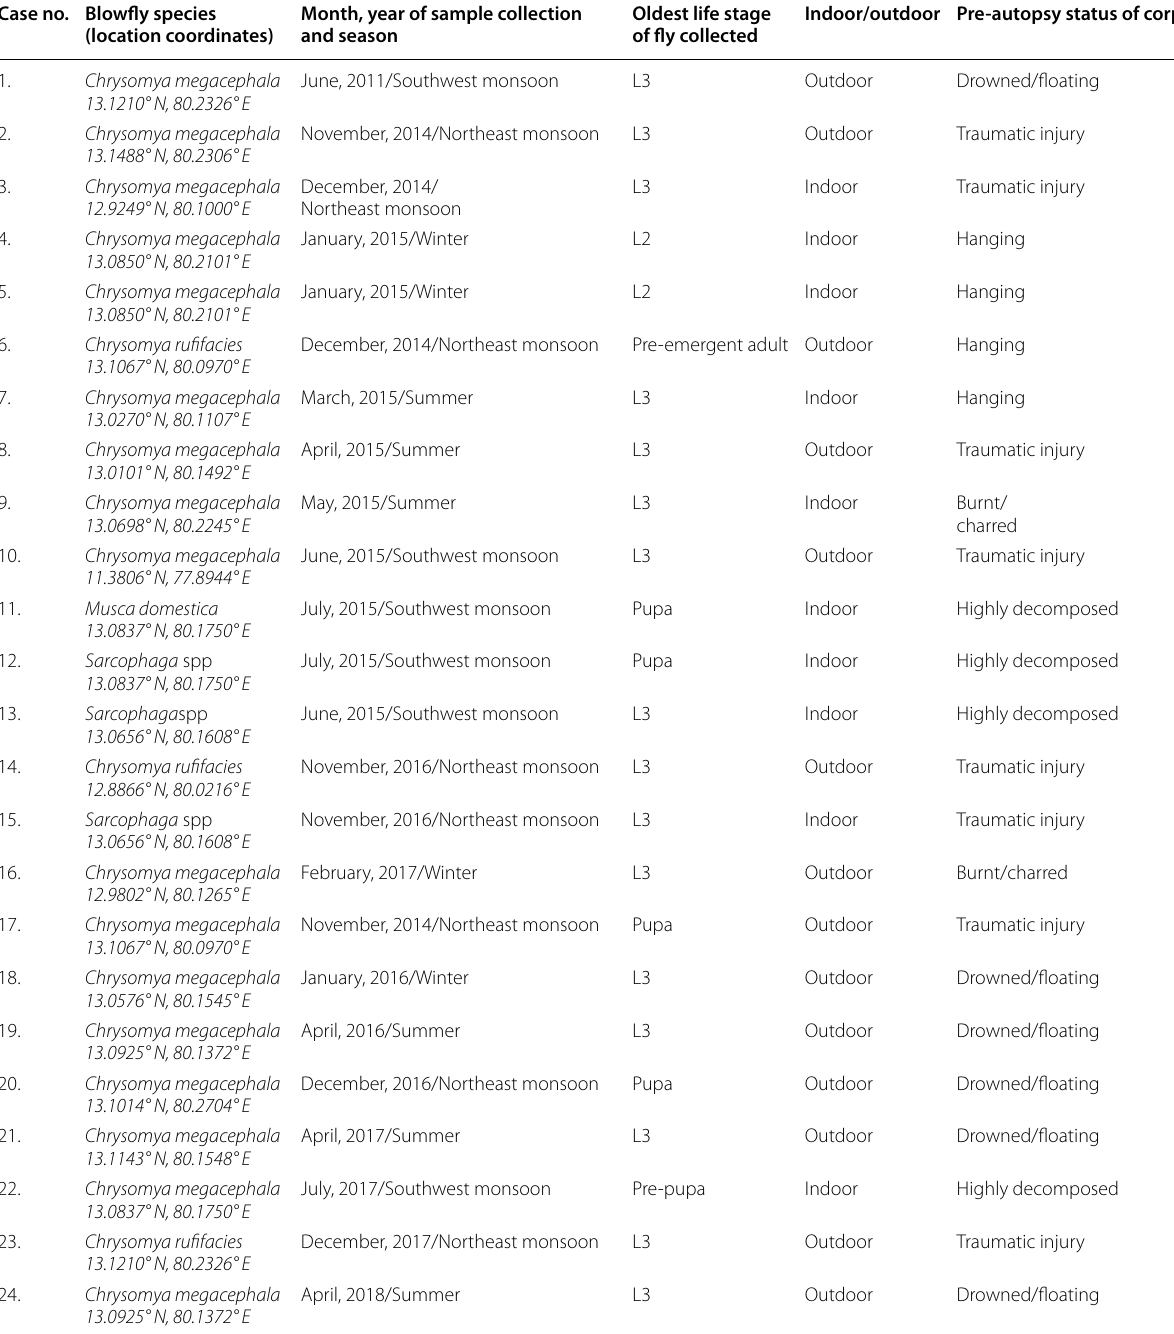
Table 1 Details on location coordinates, month and season of collection, oldest stage of necrophagous flies collected from medico- legal cases, and pre-autopsy conditions of